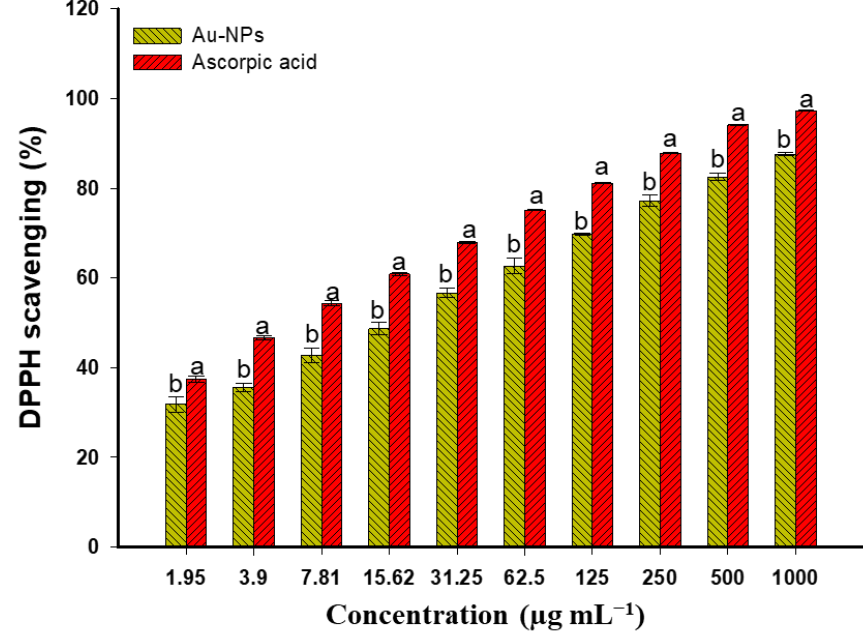
Figure 6. Antioxidant activity of plant-based AuNPs measured by DPPH method at different concentrations compared to ascorbic acid. Data show average values ± SD (n = 3). Different letters on the bars at the same concentration indicate that the mean values are significantly different (at p ≤ 0.05).